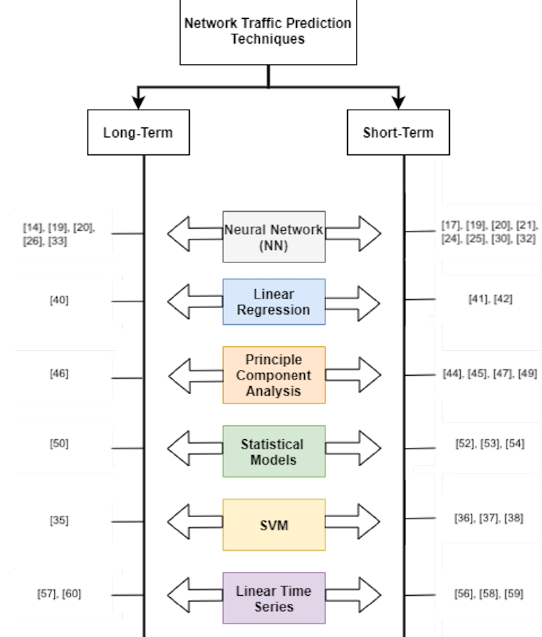
Figure 1. Structure of the